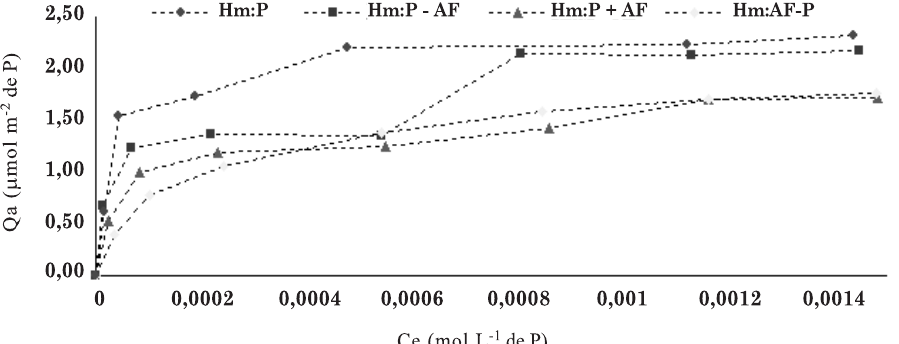
Figura 5. Isotermas de adsorção de fósforo sobre hematita sintética (Hm) na presença de ácido